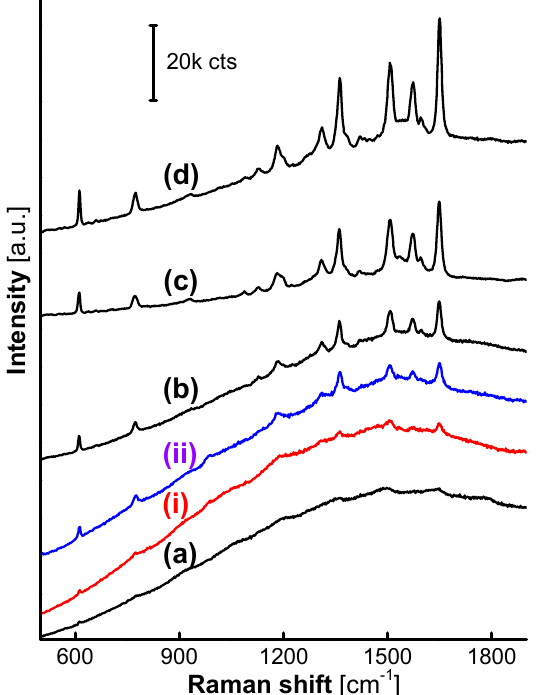
Figure 3. SERS spectra from R6G adsorbed on the AgNPs loaded on MF 1 ( a ), MF 1.5 ( i ), MF 2 ( ii ), MF 3 ( b ), MF 7 ( c ), and MF 9 ( d ). Only 1% of 20 mW was adopted in the collection of the SERS spectra.